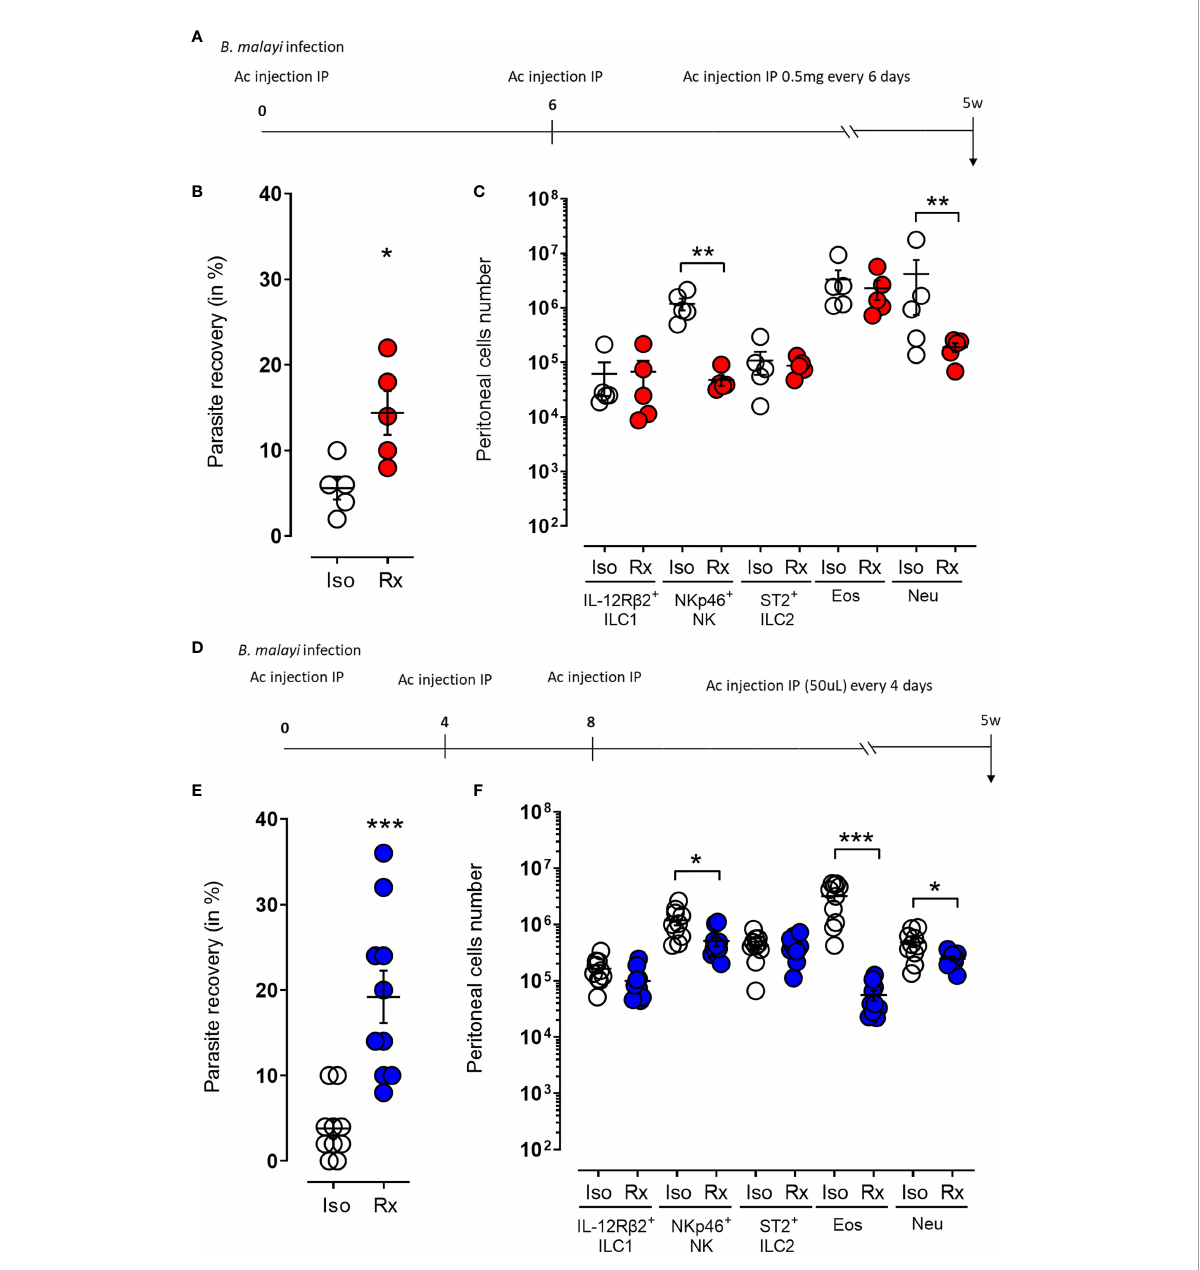
FIGURE 3 Temporal ablation of NKp46 + NK cells in RAG2 -/- mice leads to increased susceptibility to B. malayi and impaired granulocytes recruitment to the site of infection. (A) Schematic representation of the study design where B. malayi infected RAG2 -/- mice were intraperitoneally (IP) injected with 0,5mg anti-NKp46 antibody or its isotype control every 6 days until 5 weeks post-infection. (B) Parasite recovery in isotype control treated mice (Iso) or anti-NKp46 treated mice (Rx) at 5 weeks post-infection. (C) Innate lymphoid cells (IL-12R b 2 + ILC1, NKp46 + NK, ST2 + ILC2) and granulocytes (eosinophils – Eos and neutrophils – Neu) numbers in the peritoneal cavity of control (Iso) or anti-NKp46 treated (Rx) infected mice at 5 weeks post-infection. (D – F) similar study in which B. malayi infected RAG2 -/- mice were IP injected with 50µL of anti-asialoGM1 antibody or its isotype control every 4 days until 5 weeks post-infection. Respective parasite recovery is given in (E) and peritoneal cell numbers in (F) . Unpaired T-tests, n=5-10, single experiment. Signi fi cance is given as *:p < 0.05, **:p < 0.01 and ***:p <